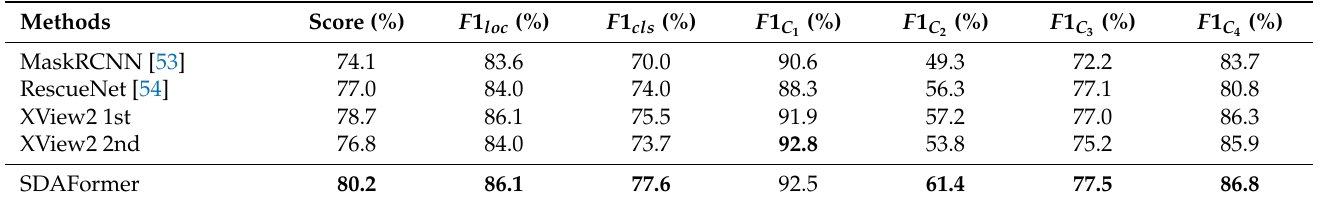
Figure 6 visualizes the damage assessment results of each method. For RescueNet, more errors appear in the damage classification, especially on the minor damage